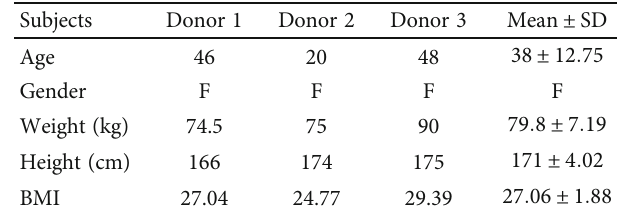
Table 1: Subjects